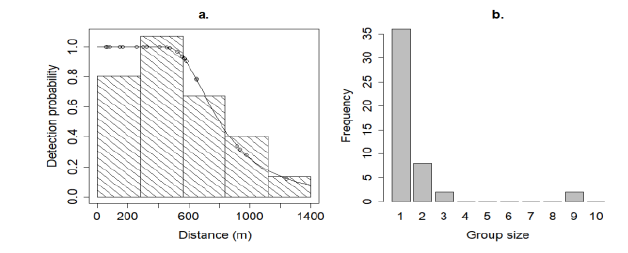
Figure 9. a. Detection function for bowhead whales in Isabella Bay (line is the fitted model). b. Group sizes within truncation distance in Isabella Bay.